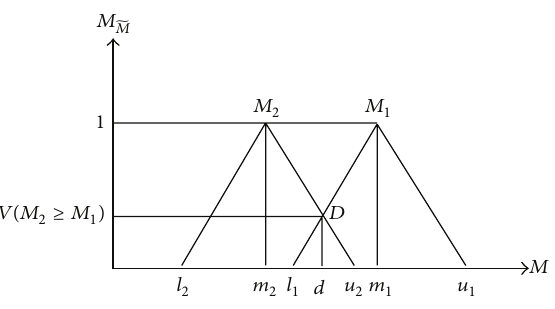
Figure 3: The intersection between 𝑀 1 and 𝑀 2